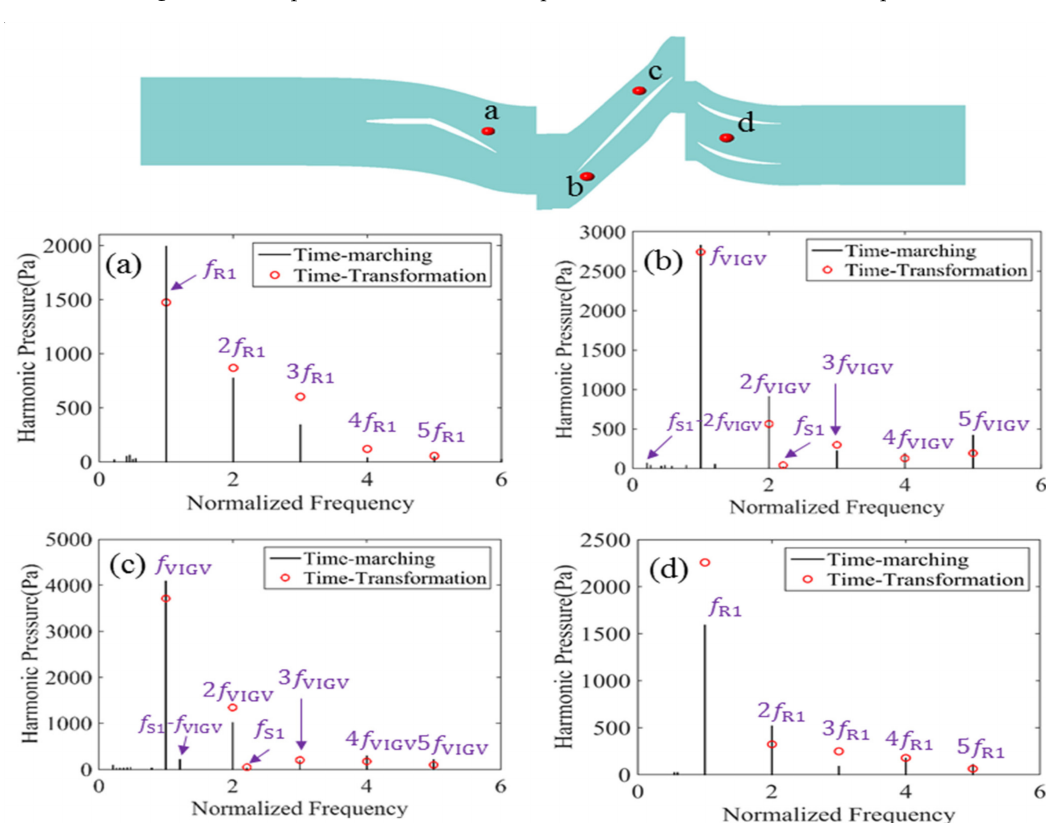
Figure 13. Comparison of the pressure spectrum for the four